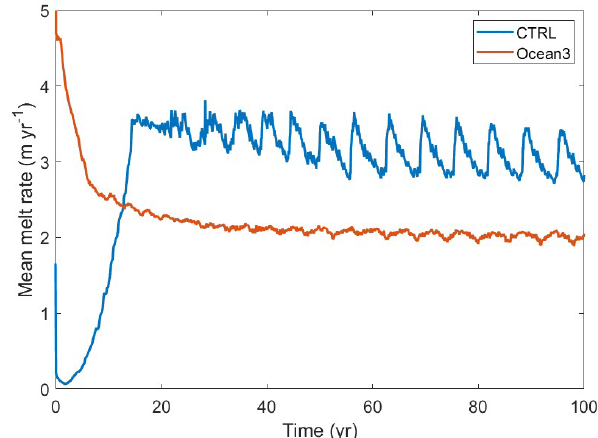
Figure A2. Simulated mean melt rate from CTRL and